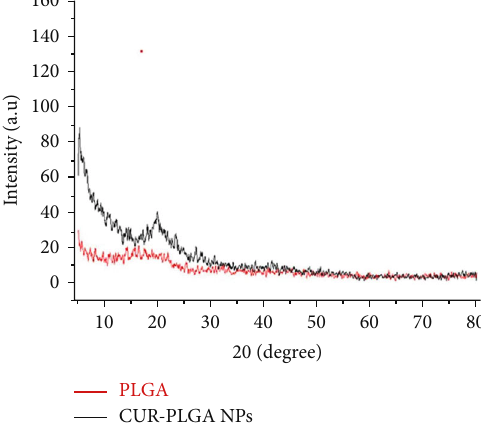
Figure 3: XRD of PLGA and CUR-loaded PLGA